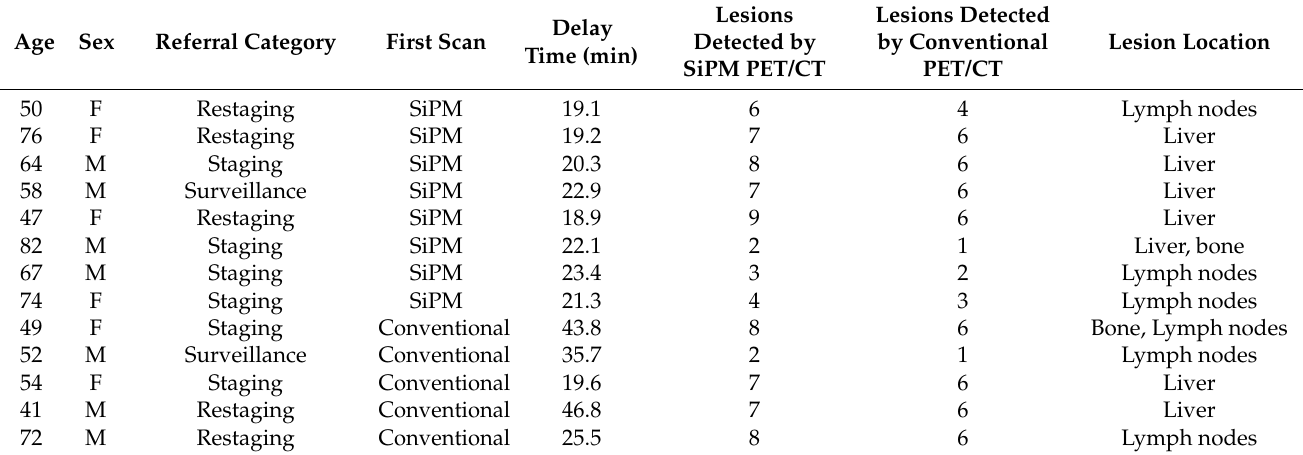
Figure 3. A 59-year-old man with metastatic small bowel NET, referred for subsequent treatment strategy after small bowel resection. Conventional PET/CT was performed first at 85 min after injection of 4.5 mCi of 68 Ga-DOTA-TATE. SiPM-based PET/CT was performed second at 110 min after injection. Red arrows mark an additional lesion seen in the right lobe of the liver only on SiPM-based PET/CT ( B3 , B4 , E ) not on conventional PET/CT ( A , B1 , B2 ). Blue arrows mark liver lesions seen on conventional PET/CT ( A , C1 , C2 , D1 , D2 ) but more conspicuous on SiPM-based PET/CT ( C3 , C4 , D3 , D4 , E ). Table 4. Characteristics of the 13 participants who had lesions detected only with SiPM